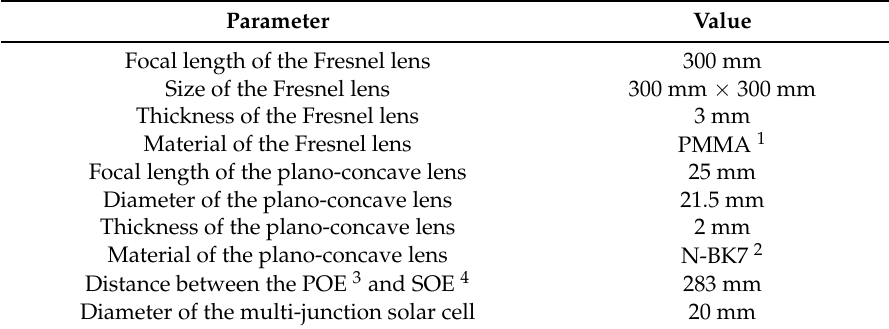
Table 1. Design parameters of the concentrator photovoltaic (CPV) unit.